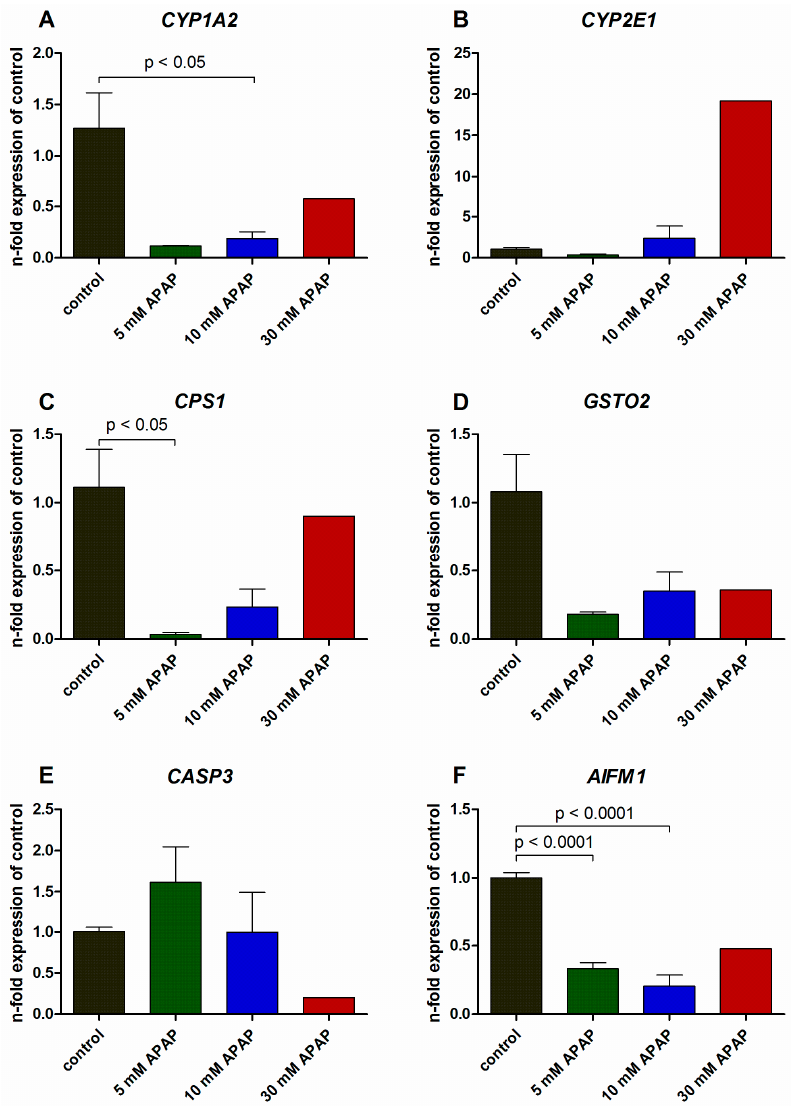
Figure 5. Gene expression analysis of primary human liver cells after culture in bioreactors